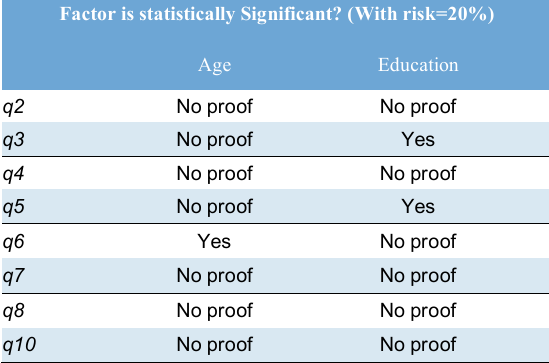
Tab. 3. Outputs of ANOVA Analysis on relevant